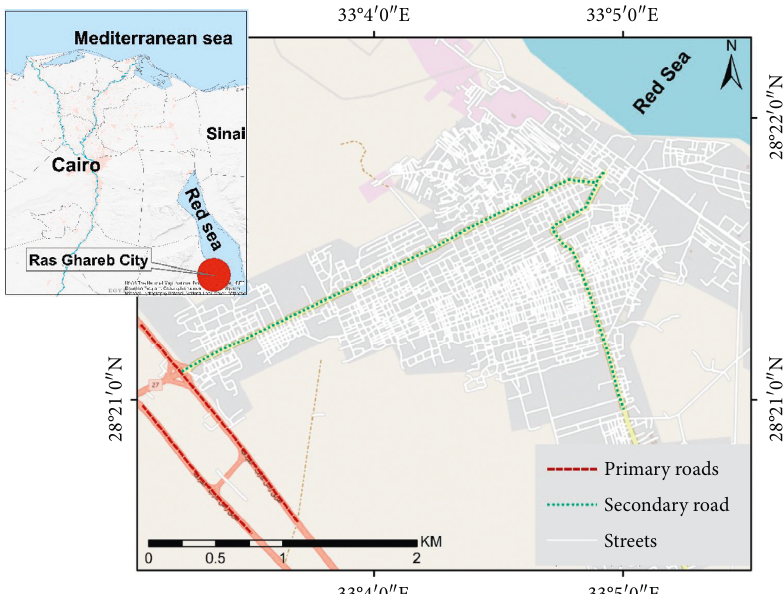
Figure 1: The location of the study area of Ras Ghareb City.